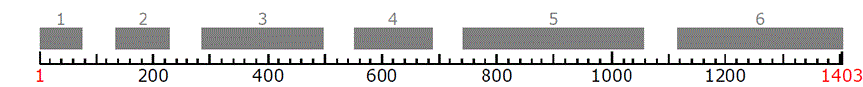
Figure 1. The structure of EF1 α partial gene from the Phlebiopsis gigantea . The positions for exons are presented respectively: exon 1 (1–75), exon 2 (134–228), exon 3 (284–496), exon 4 (550–686), exon 5 (739–1056), exon 6 (1113–1403). (mRNA) 1–6 exon (s): 1–1403. The numbers indicate the positions of the bases identified using FGENESH software.